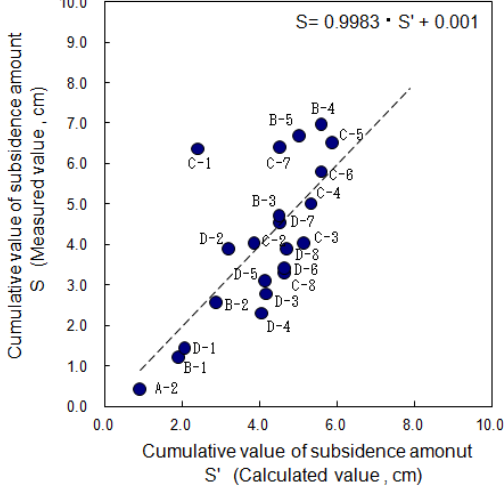
Figure 12. Comparison of Measured value and Calculated value of land